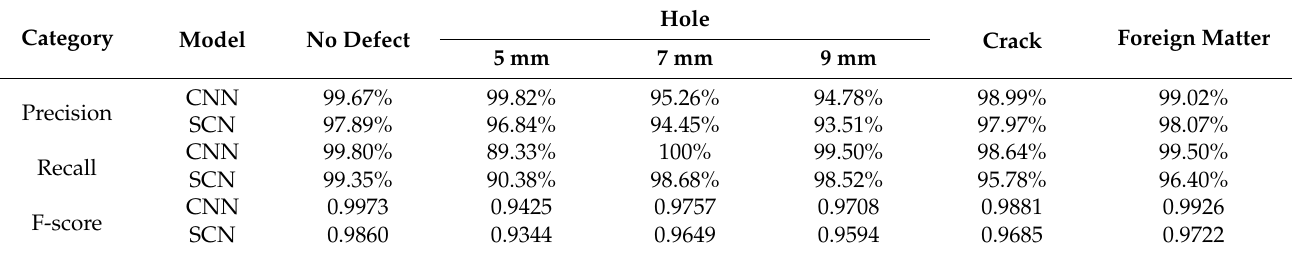
Table 5. Average values of six-classifying model evaluation